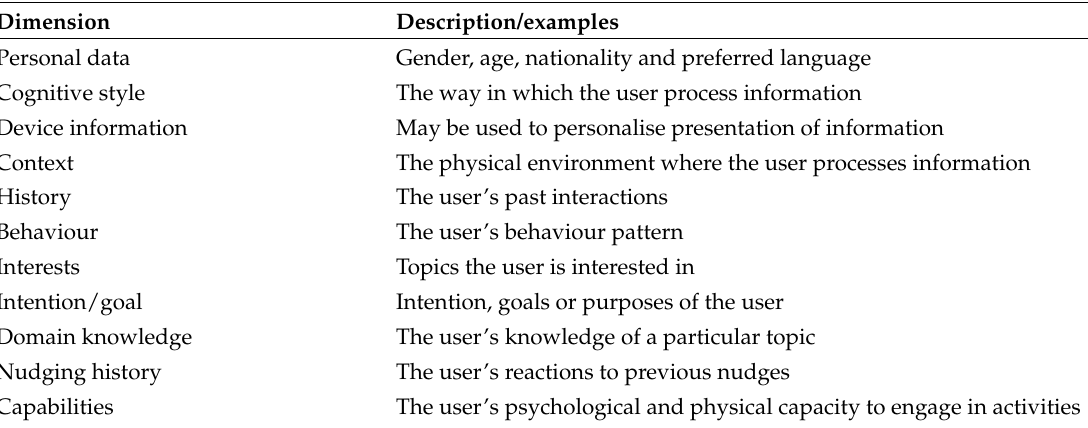
Table 2. Main user profile